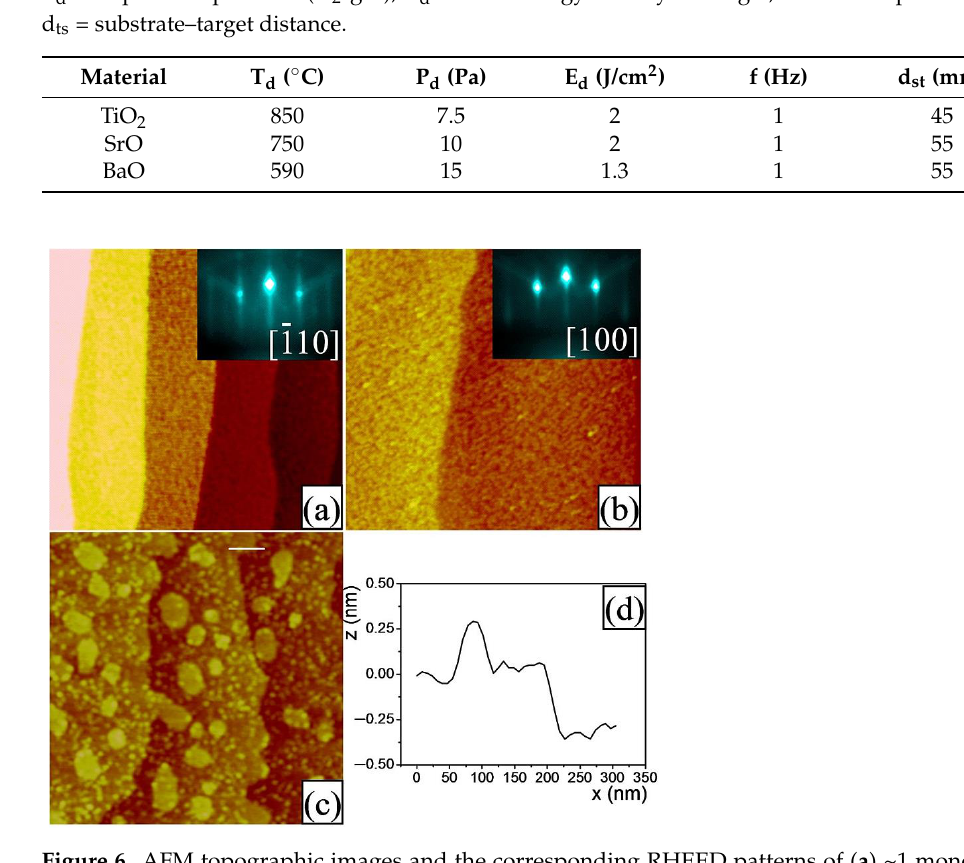
the annealed NdGaO 3 substrate features a NdO 1+x termination, thereby confirming the results from Ref. [36]. Table 2. Deposition parameters for the MeO (Me = Ti, Sr, Ba) thin films. T d = deposition temperature, P d = deposition pressure (O 2 gas), E d = laser energy density on target, f = laser repetition rate, d ts = substrate – target distance.